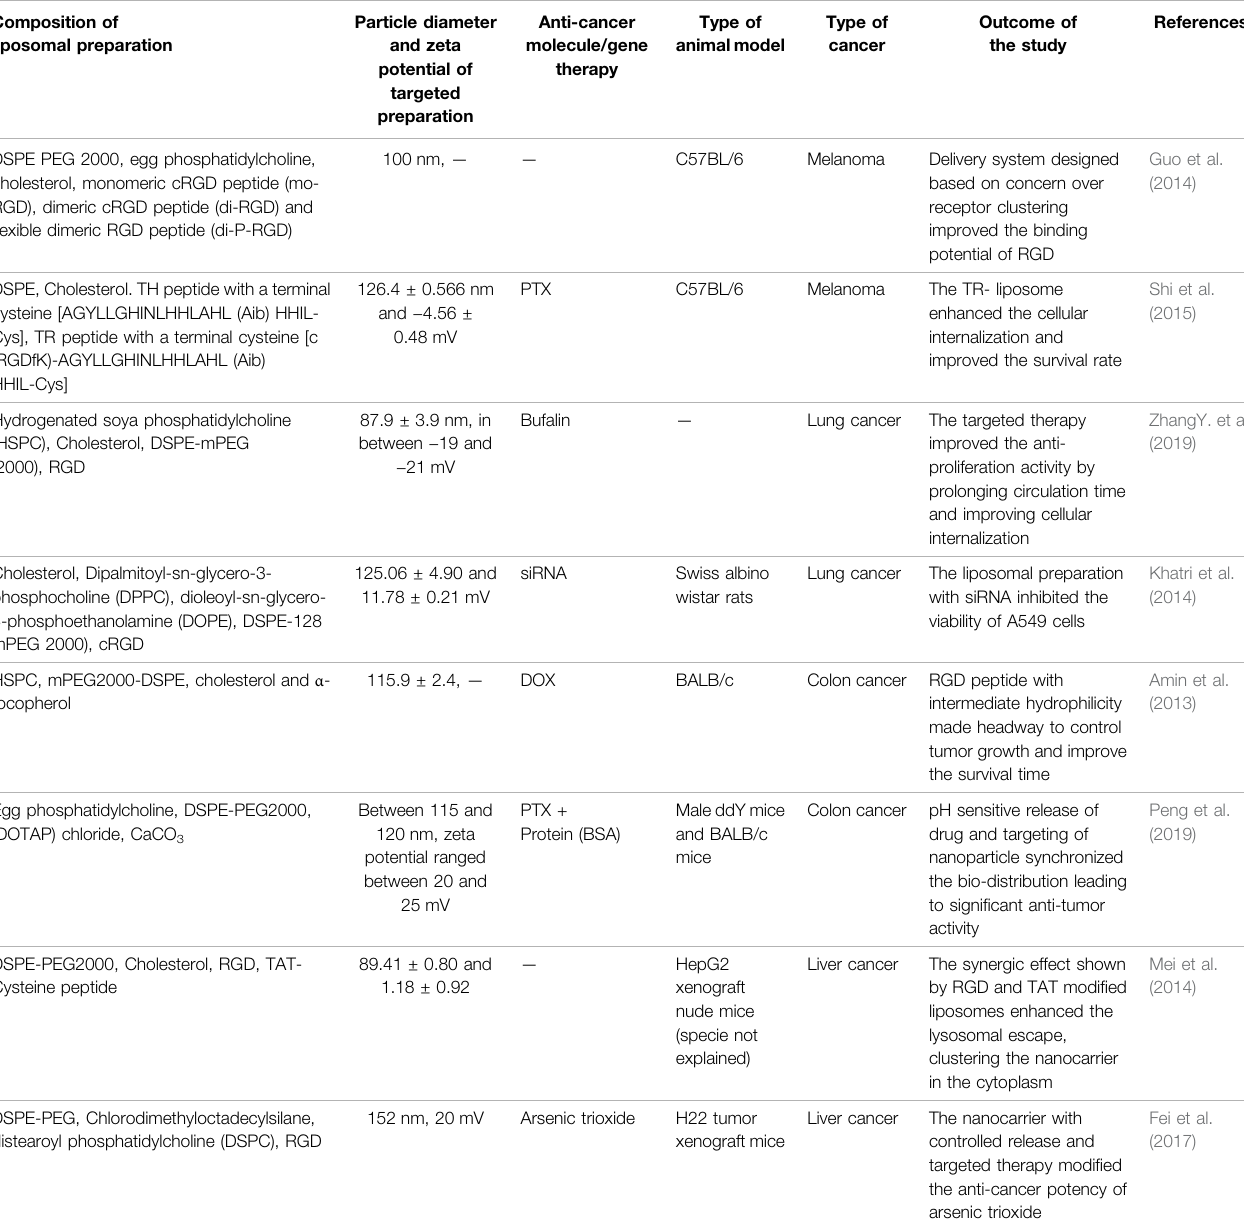
TABLE 1 | ( Continued ) Representation of Integrin targeted Liposomal preparation modi fi ed with RGD peptide. Composition of liposomal